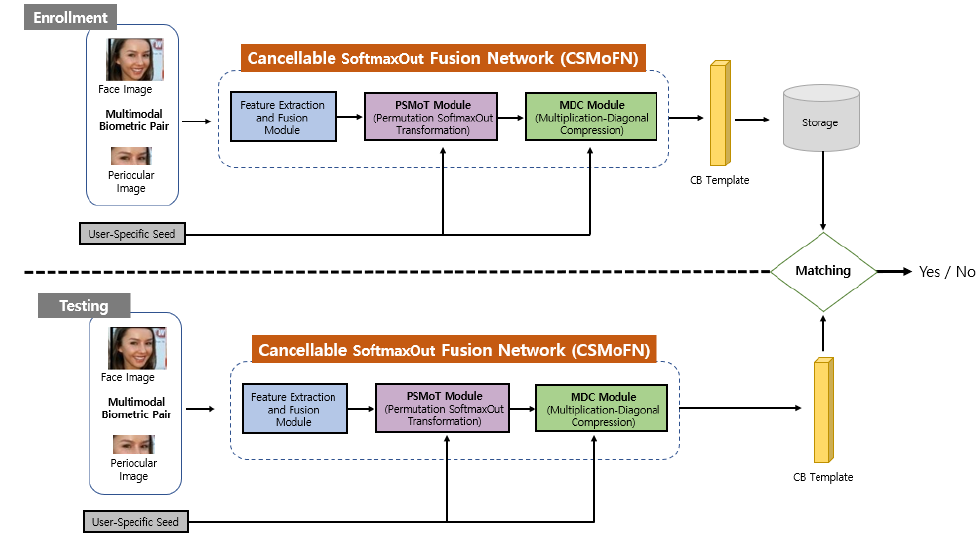
Figure 3. Overview of the proposed CSMoFN model.